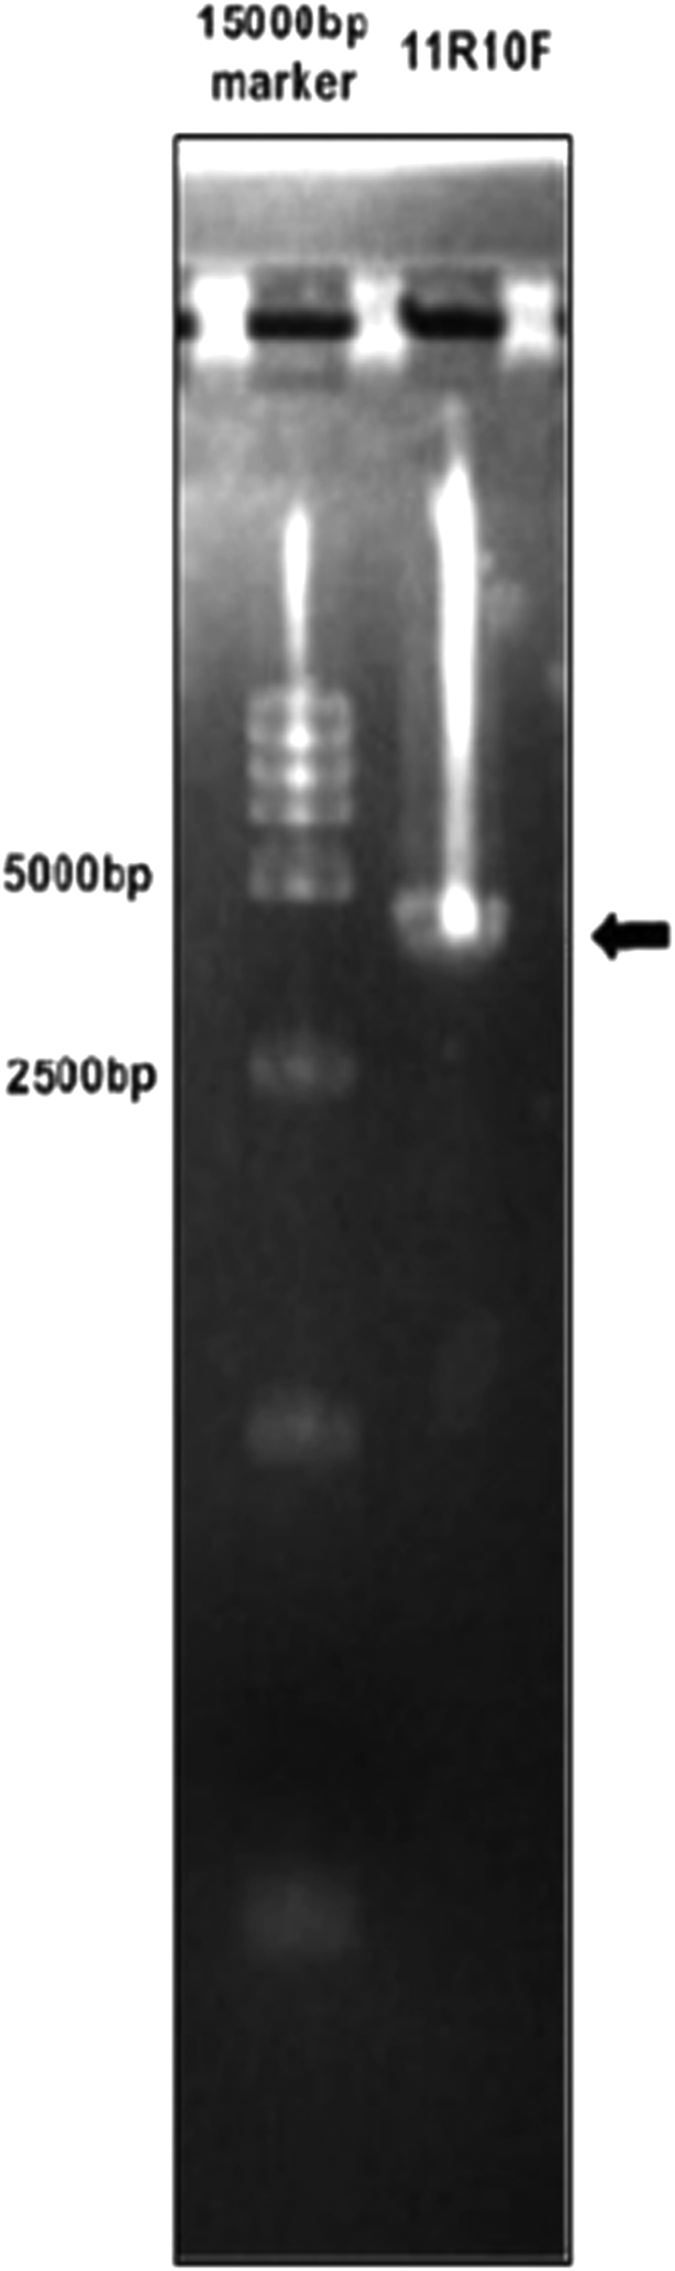
SCCmec conjunction PCR product of 3503VR6.